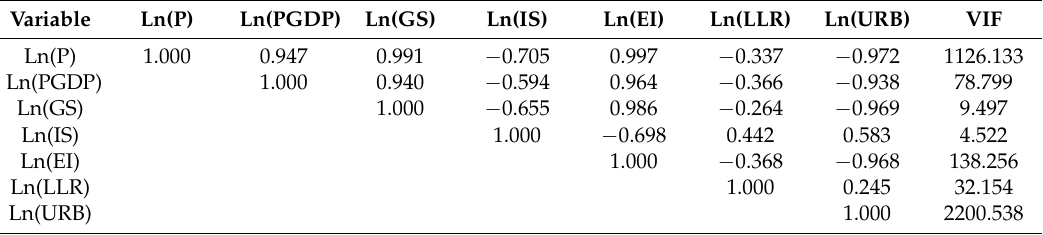
Table 4. The results of correlation